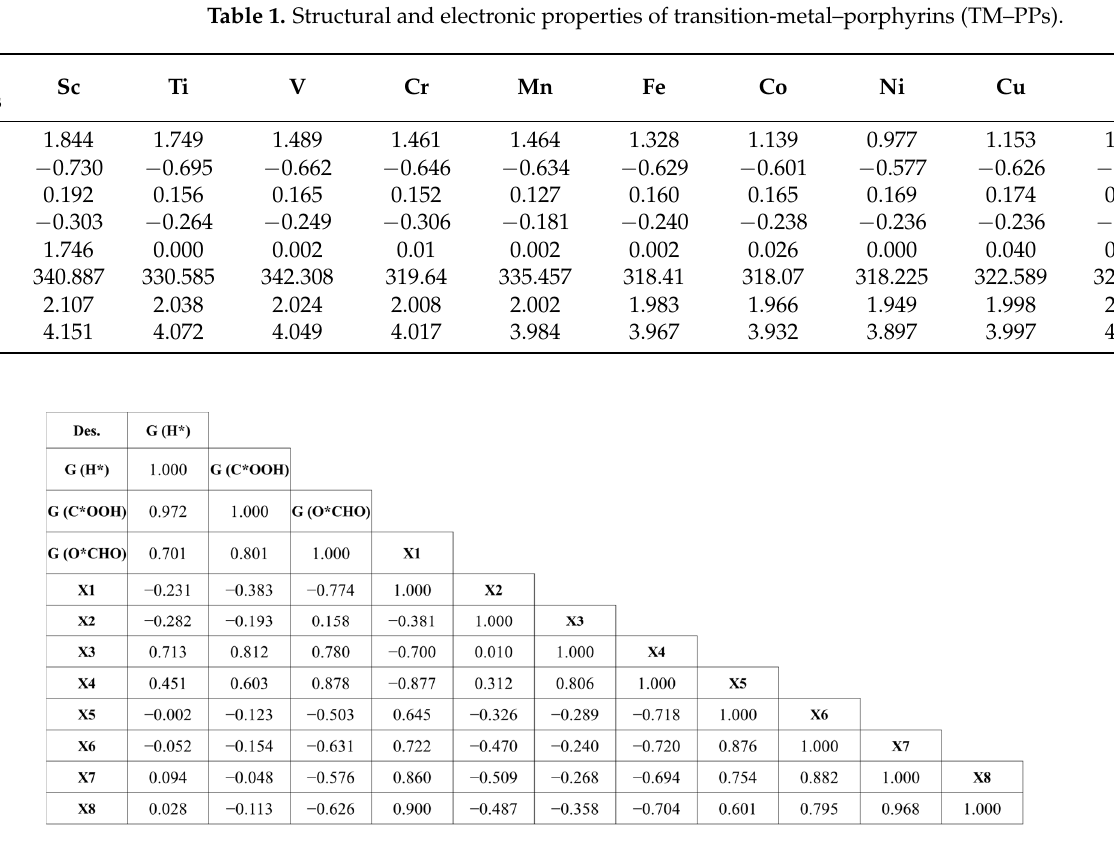
Figure 4. Pearson correlation coefficients between the three Gibbs free energies and the eight prop- erties obtained from DFT of the TM–PP